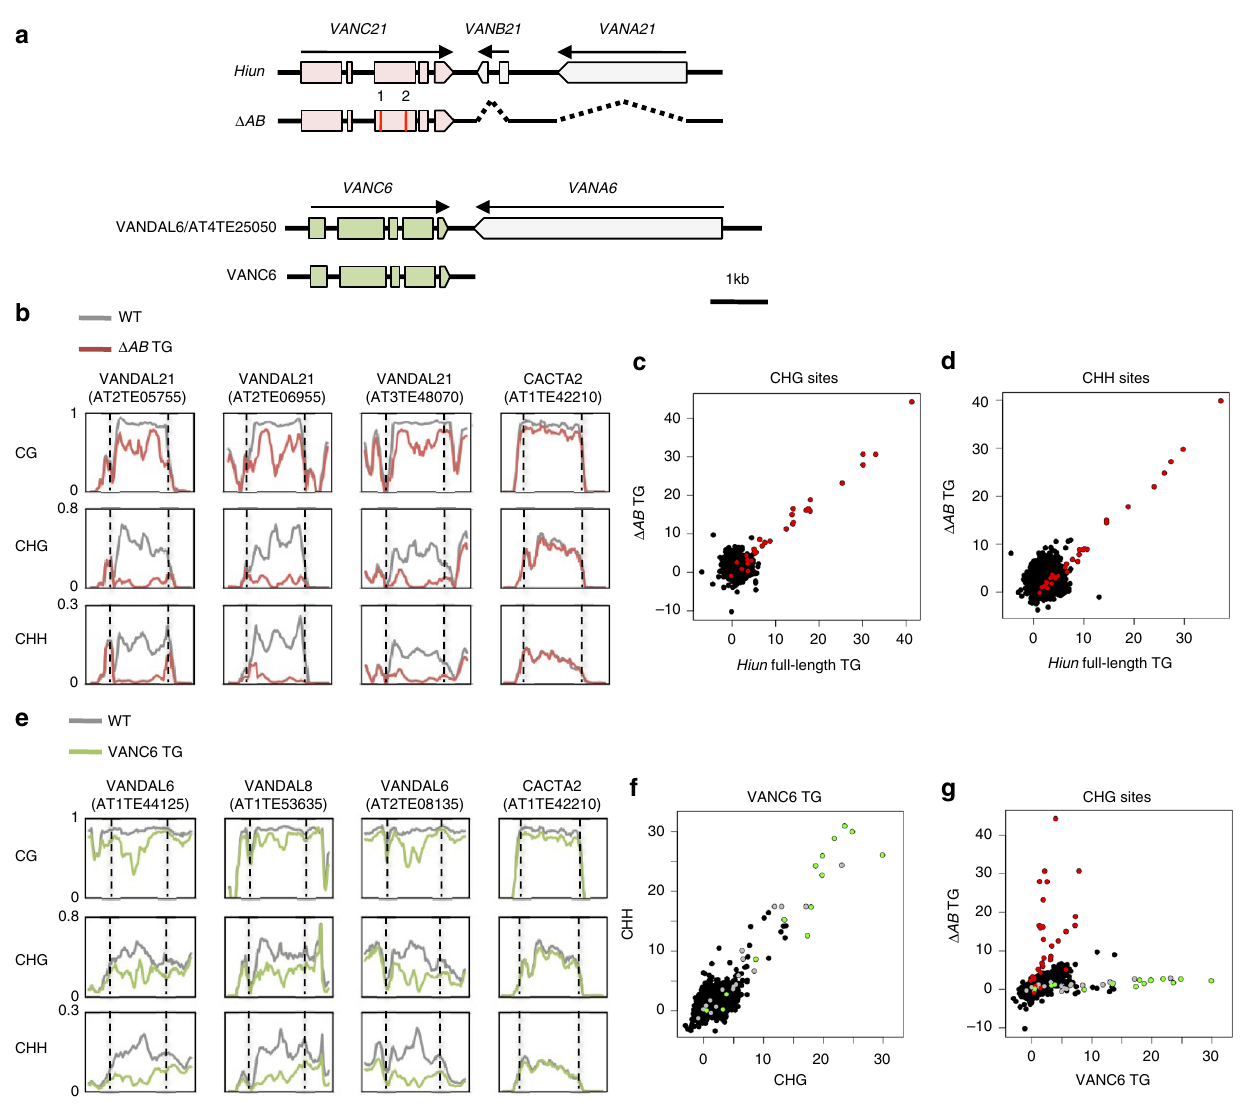
Fig. 1 Sequence-speci fi c hypomethylation by VANC proteins. a Schematic diagram of structures of VANDAL transposons and the modi fi ed transgenes used. Boxes indicate exons. Vertical red lines show the positions of two nonsense mutations in VANC21 (Supplementary Fig. 2). b DNA methylation levels of VANDAL21 copies in Δ AB transgenic plants and parental wild-type plants (WT). Broken lines show TE ends. Each point represents proportion of methylated cytosine for a sliding window with seven fractions after separating each TE for 100 fractions. Right and left fl anking regions are also analyzed by the same conditions. c , d Comparison of DNA hypomethylation between full-length Hi and Δ AB transgenic plants for CHG ( c ) and CHH sites ( d ). VANDAL21 copies are colored red. e , f Hypomethylation effects of VANC6 transgene. In e , conditions are as in b . In f , DNA hypomethylation is shown for each TE at CHG sites and CHH sites. VANDAL6 copies and VANDAL8 copies are colored green and gray, respectively. g Comparison of DNA hypomethylation between Δ AB and VANC6 transgenic plants at CHG sites. Results at CHH sites are shown in Supplementary Fig. 1f – h. In the panels c , d , f , and g , TEs more than 1 kb long are plotted ( N = 5866). The signi fi cance of decrease in DNA methylation was assessed by the value ffiffiffiffiffiffi p Mn = Cn (cid:1) Mt = Ct ð Þ = 1 = Cn transgenic ( n ) and transgenic ( t ) plants, respectively 18 . This value shows the signi fi cance by weighing the change in the methylation ratio with root of the count number. Effects of Δ AB and VANC6 transgenes on DNA methylation status of TEs longer than 1 kb are also shown in Supplementary Data CG sites (Fig. 2d, e), re fl ecting a spread of hypomethylation to surrounding regions extending to entire TEs (Figs. 1b, 2b).